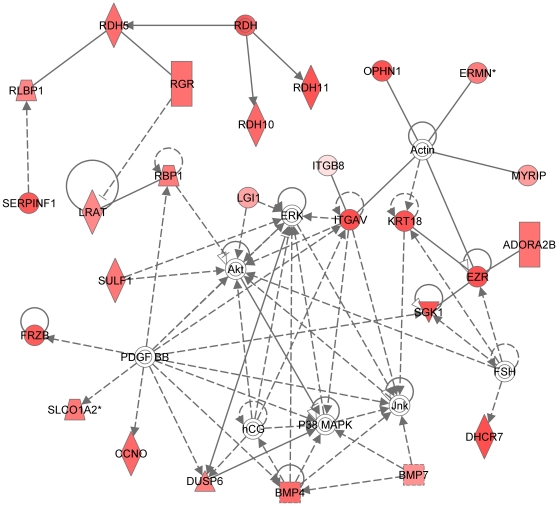
Most significant molecular network generated by the Ingenuity software.Network is generated from our dataset with RPE-specific expression (114 entries; see text). Note that the colored symbols represent gene entries that occur in our data set, while the transparent entries are molecules from the knowledge database, inserted to connect all relevant molecules in a single network. Solid lines between molecules indicate direct physical relationships between molecules (such as regulating and interacting protein domains); dotted lines indicate indirect functional relationships (such as co-regulation of expression of both genes in cell lines). Abbreviation of gene names are according to standard abbreviations used in Genbank [29]. The main functionalities given by Ingenuity for this molecular network are Nervous system development and function, Visual system development and function, organismal development. This network overlaps with the network in Figure 2). Highlights in this network include: (a) the regulating role of the MAPK/ERK pathway, a very complex signal transduction pathway that couples intracellular responses to the binding of growth factors to cell surface receptors; (b) platelet-derived growth factor (PDGF BB), known to induce RPE cell proliferation and migration and the development of proliferative vitreoretinopathy (PVR), acts indirectly on multiple molecules in this network, and c) the RPE retinol metabolism is present in the periphery of this molecular network.